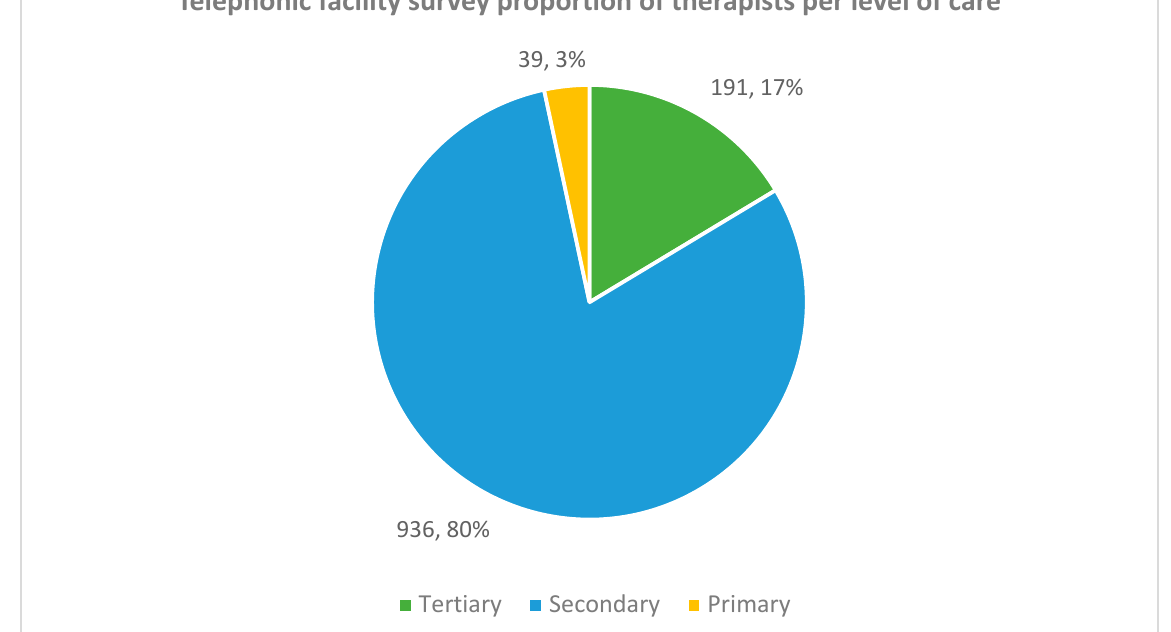
Figure 7. Telephonic facility survey of therapists per level of care.